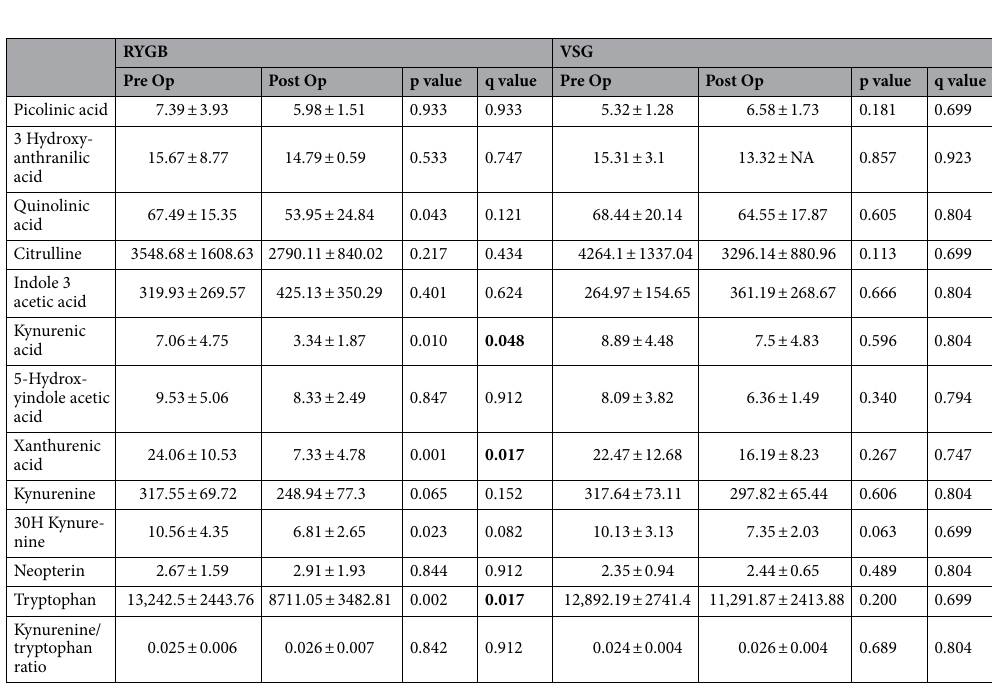
Table.4. Effect of surgery by surgical procedure subgroup on measured metabolites. q values were generated using the Benjamini and Hochberg method to control the false discovery rate (FDR). Units of all of metabolites displayed—ng/ml. KTR expressed as a ratio. Significant values are indicated by bold